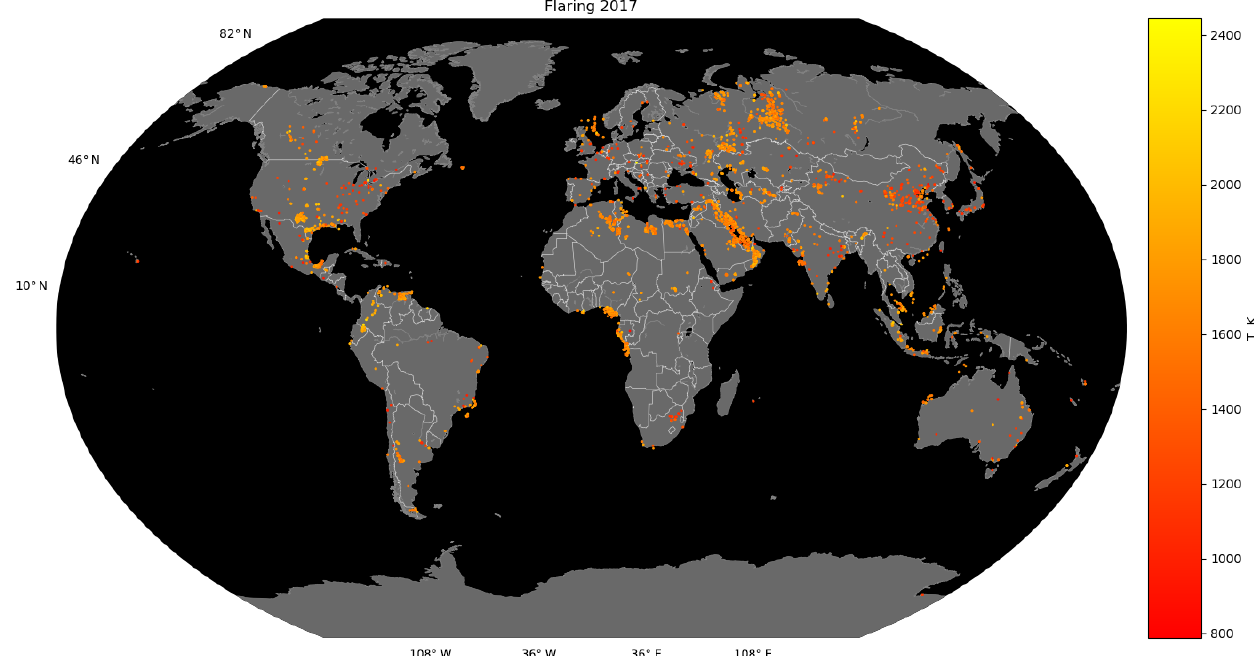
Figure 8. Average flaring temperature (K) at the 6232 flaring